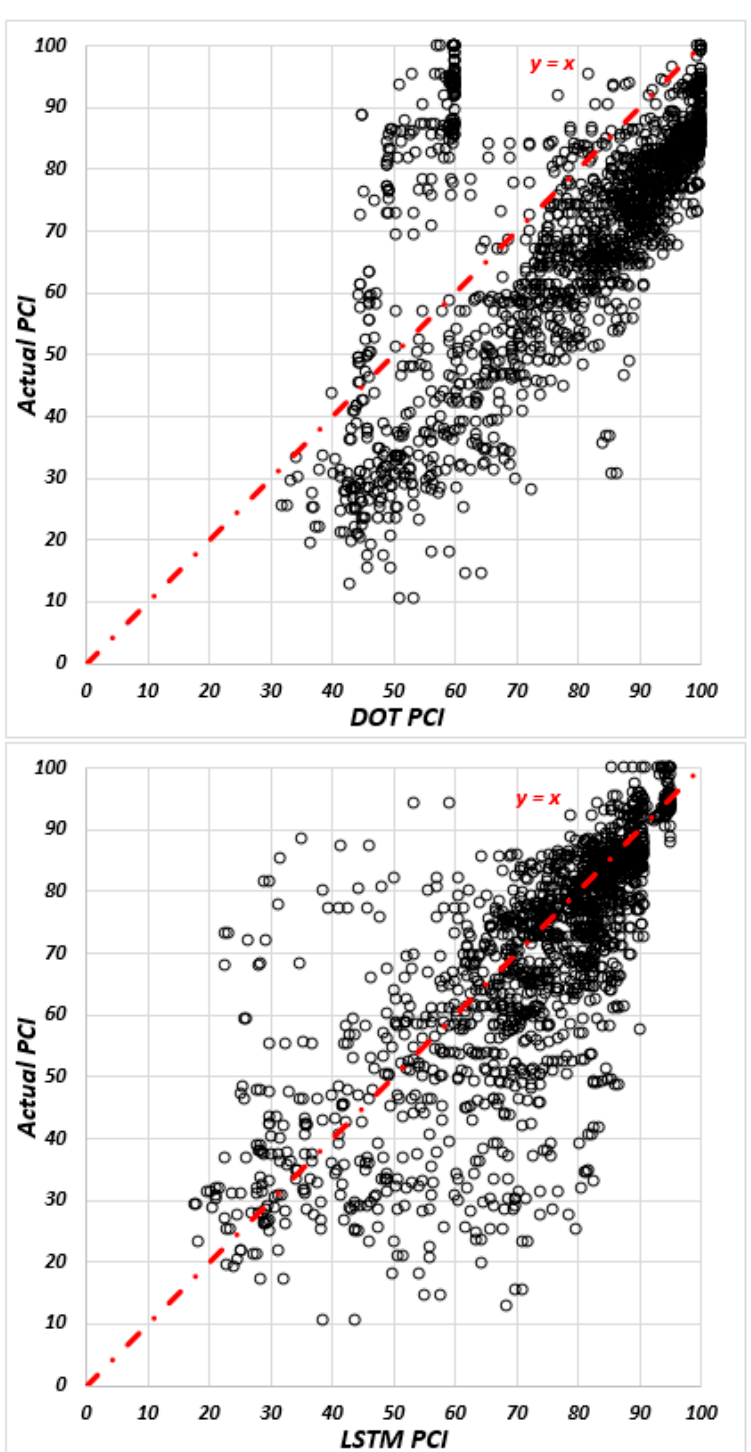
Figure 6. The actual PCI over predicted PCI in PCC sections for DOT and LSTM models, respectively. Additionally, the results for the COM pavements show that the LSTM model obtained a higher prediction accuracy. The R-square values were 0.43 for the riding index, 0.19 for the rutting index, 0.39 for the cracking index, and 0.50 for the PCI in LSTM models while the corresponding values for the DOT models were − 0.02, − 4.7, − 0.05, and 0.11, respectively. Additionally, the SEE metrics for both models indicate that the LSTM model obtained less standard error of estimate, compared to